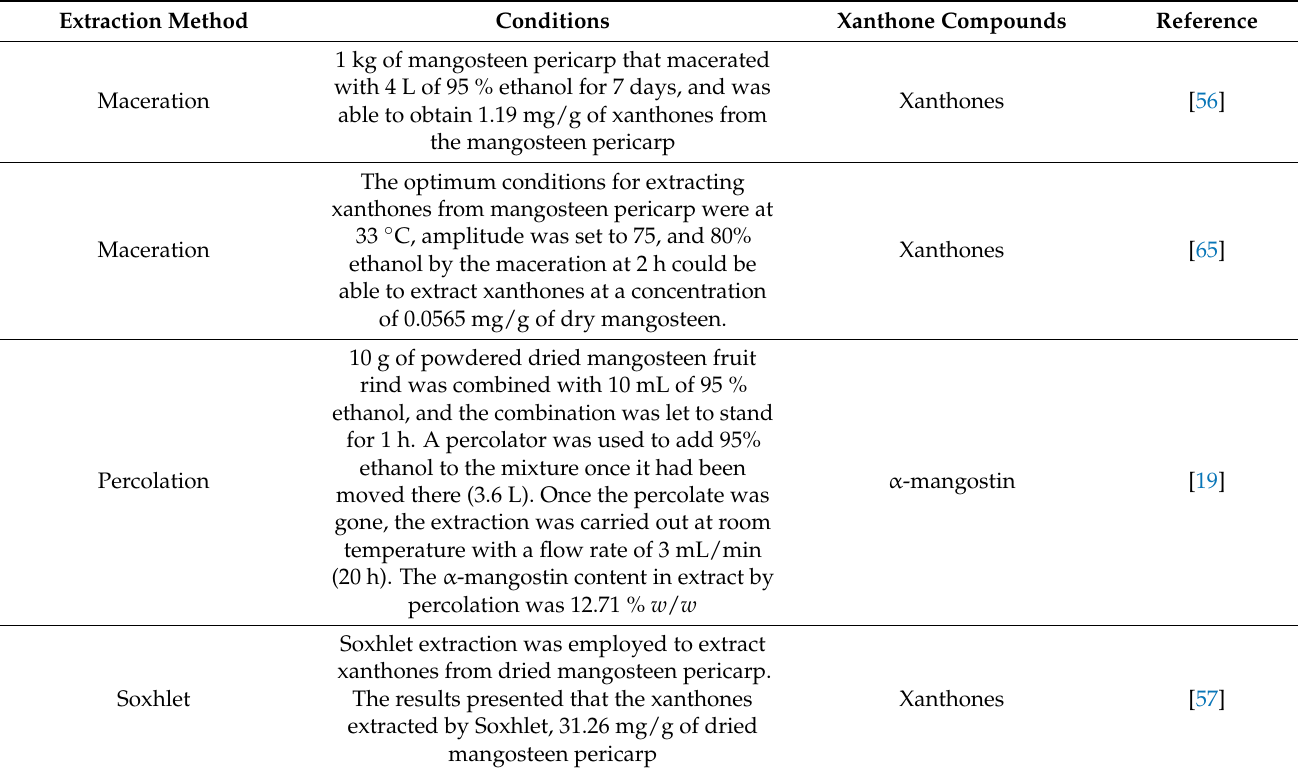
Table 3. A comparison of xanthones, α -mangostin content from the mangosteen pericarp extract by traditional